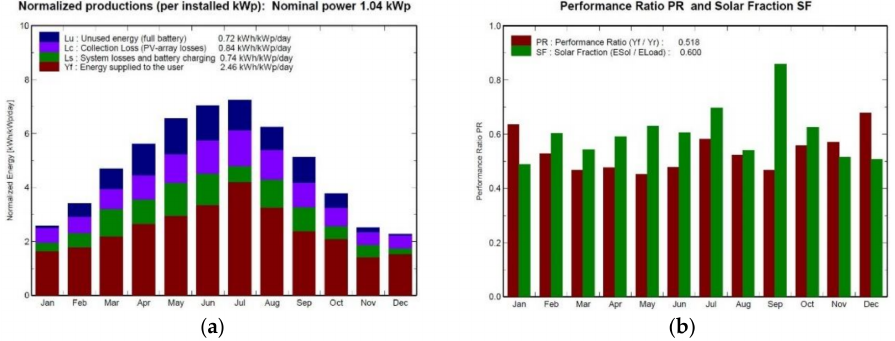
Figure 13. Results of PVSYST simulations: energy generation ( a ) and performance ratio (PR); ( b ) for each month of the